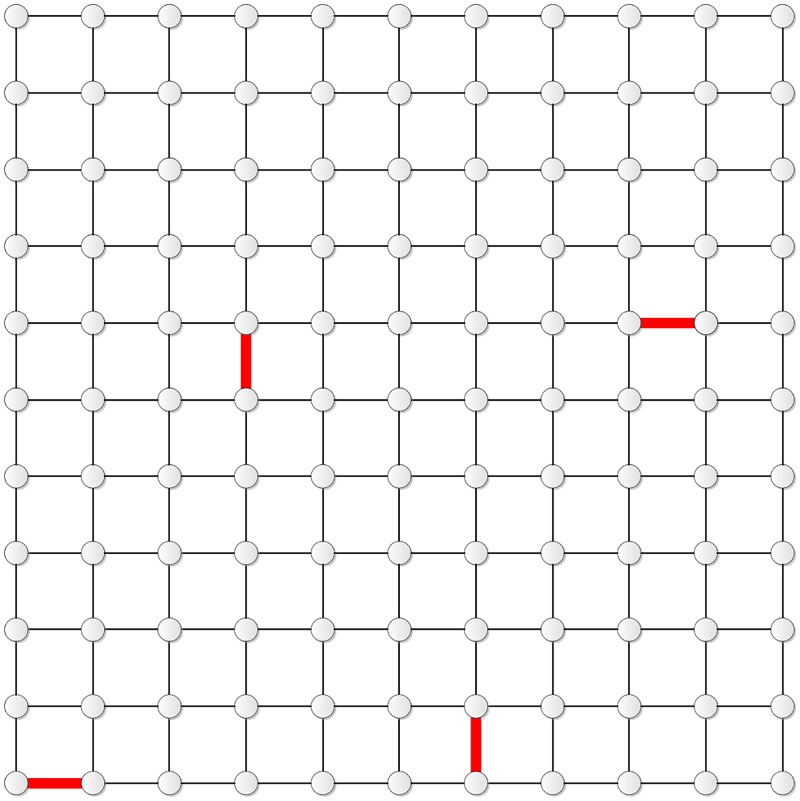
The distribution of the four edges in T11.